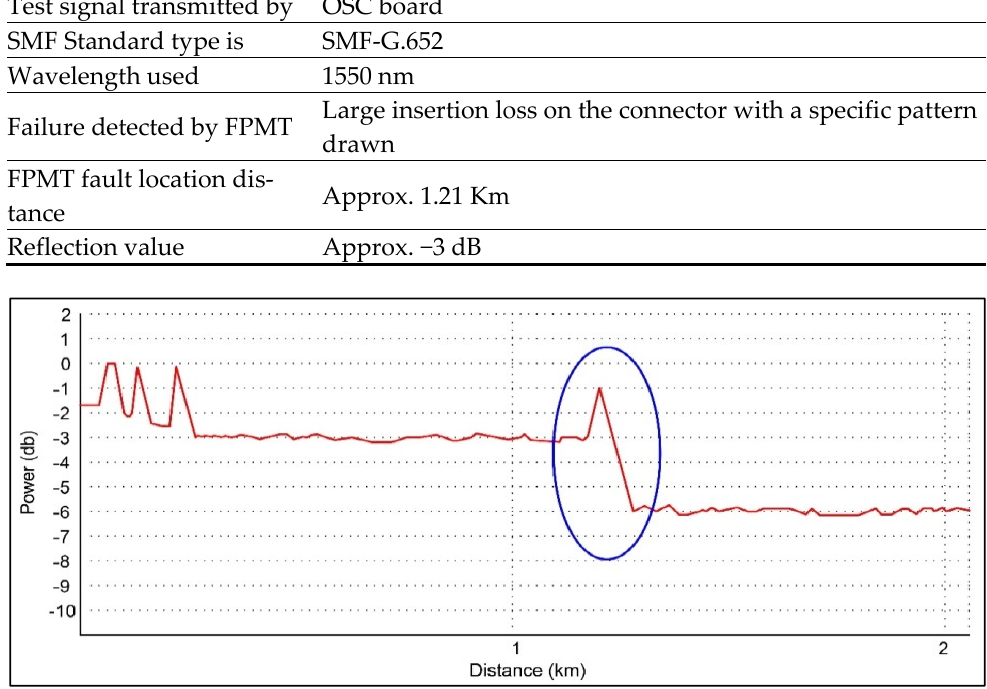
Figure 12. Event is fiber large insertion loss on the connector the (standard SMF G.652 at 1550 nm was used and FPMT test signal was transmitted by the OSC board).